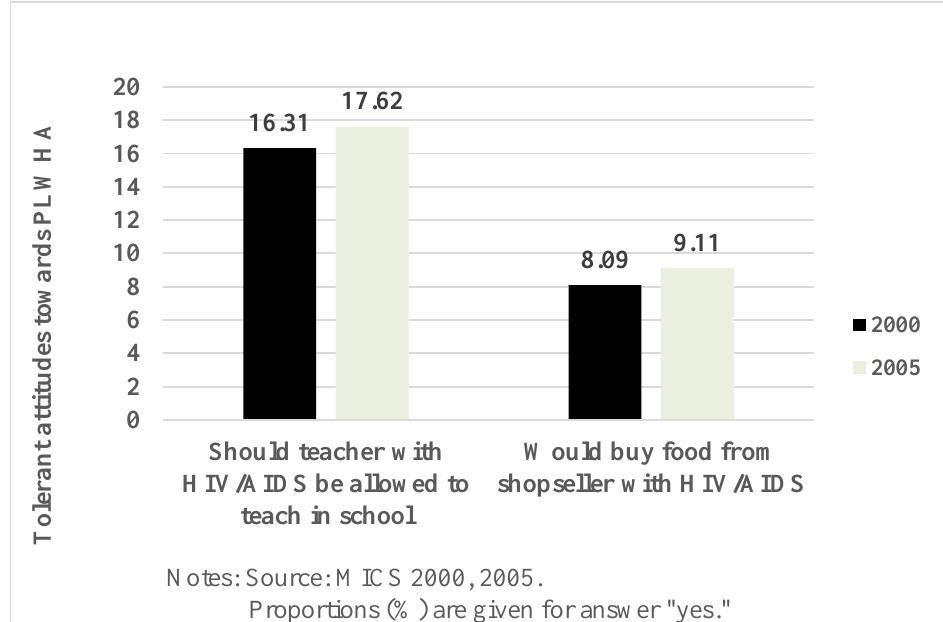
Figure 1. Trends in positive attitudes towards people living with HIV/AIDS captured through variables such as age (ranging from 15 to 49 years old), marital status (currently married versus all else), region of residence (a series of five dummy variables: Dushanbe, Khatlon, Sogd, Direct Rule Districts (DRDs) and Gorno-Badakhshan Autonomous Region (GBAO)), and area of residence (rural versus urban). Socioeconomic status measures were education (higher versus all else), and household income (recoded as tertiles: low, medium and high). The study used a dichotomous variable ‘year 2005’ that contrasted respondents who participated in the 2005 survey with those who did